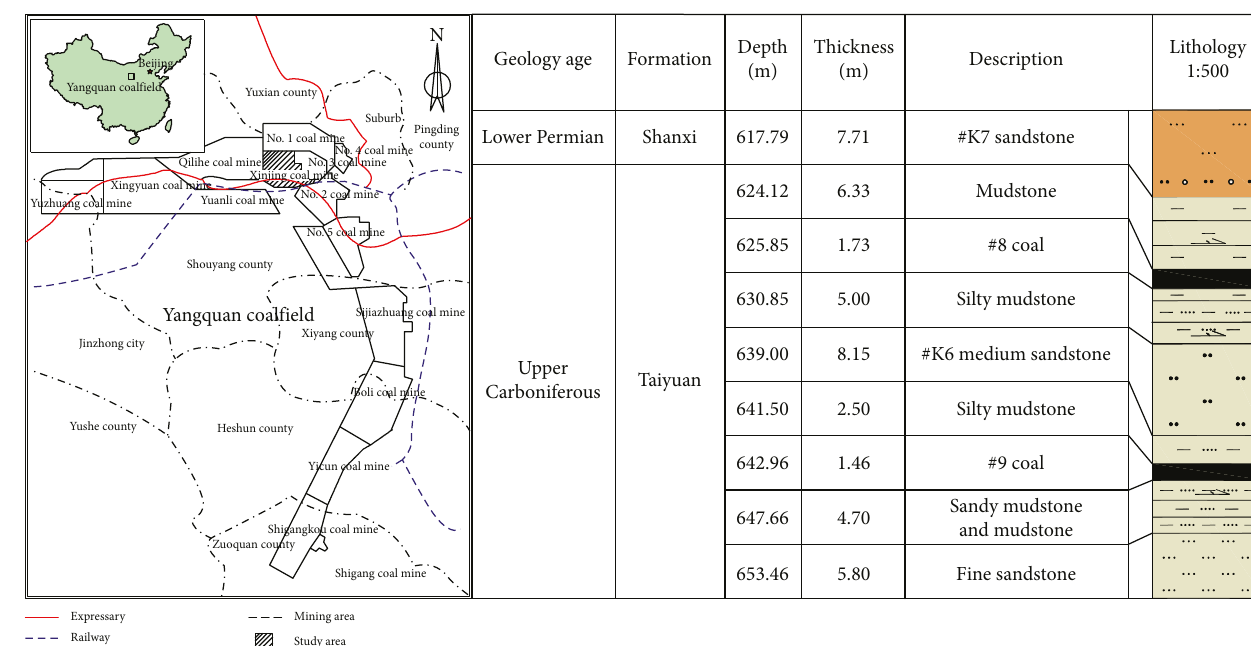
Figure 1: Study area location and detailed stratigraphic column of coal-bearing strata in the Yangquan coal fi